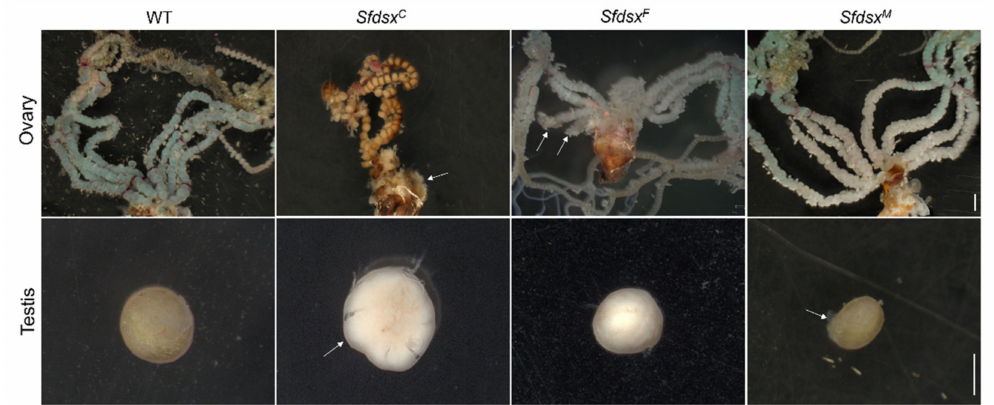
Figure 4. Malformation of ovaries and testes in adult Sfdsx mutants. The ovaries and testes of wildtype, Sfdsx C , Sfdsx F , and Sfdsx F adults were dissected on the third day post-eclosion (PAE3). White arrows indicate mutations on ovaries or testes. Scale bars: 1